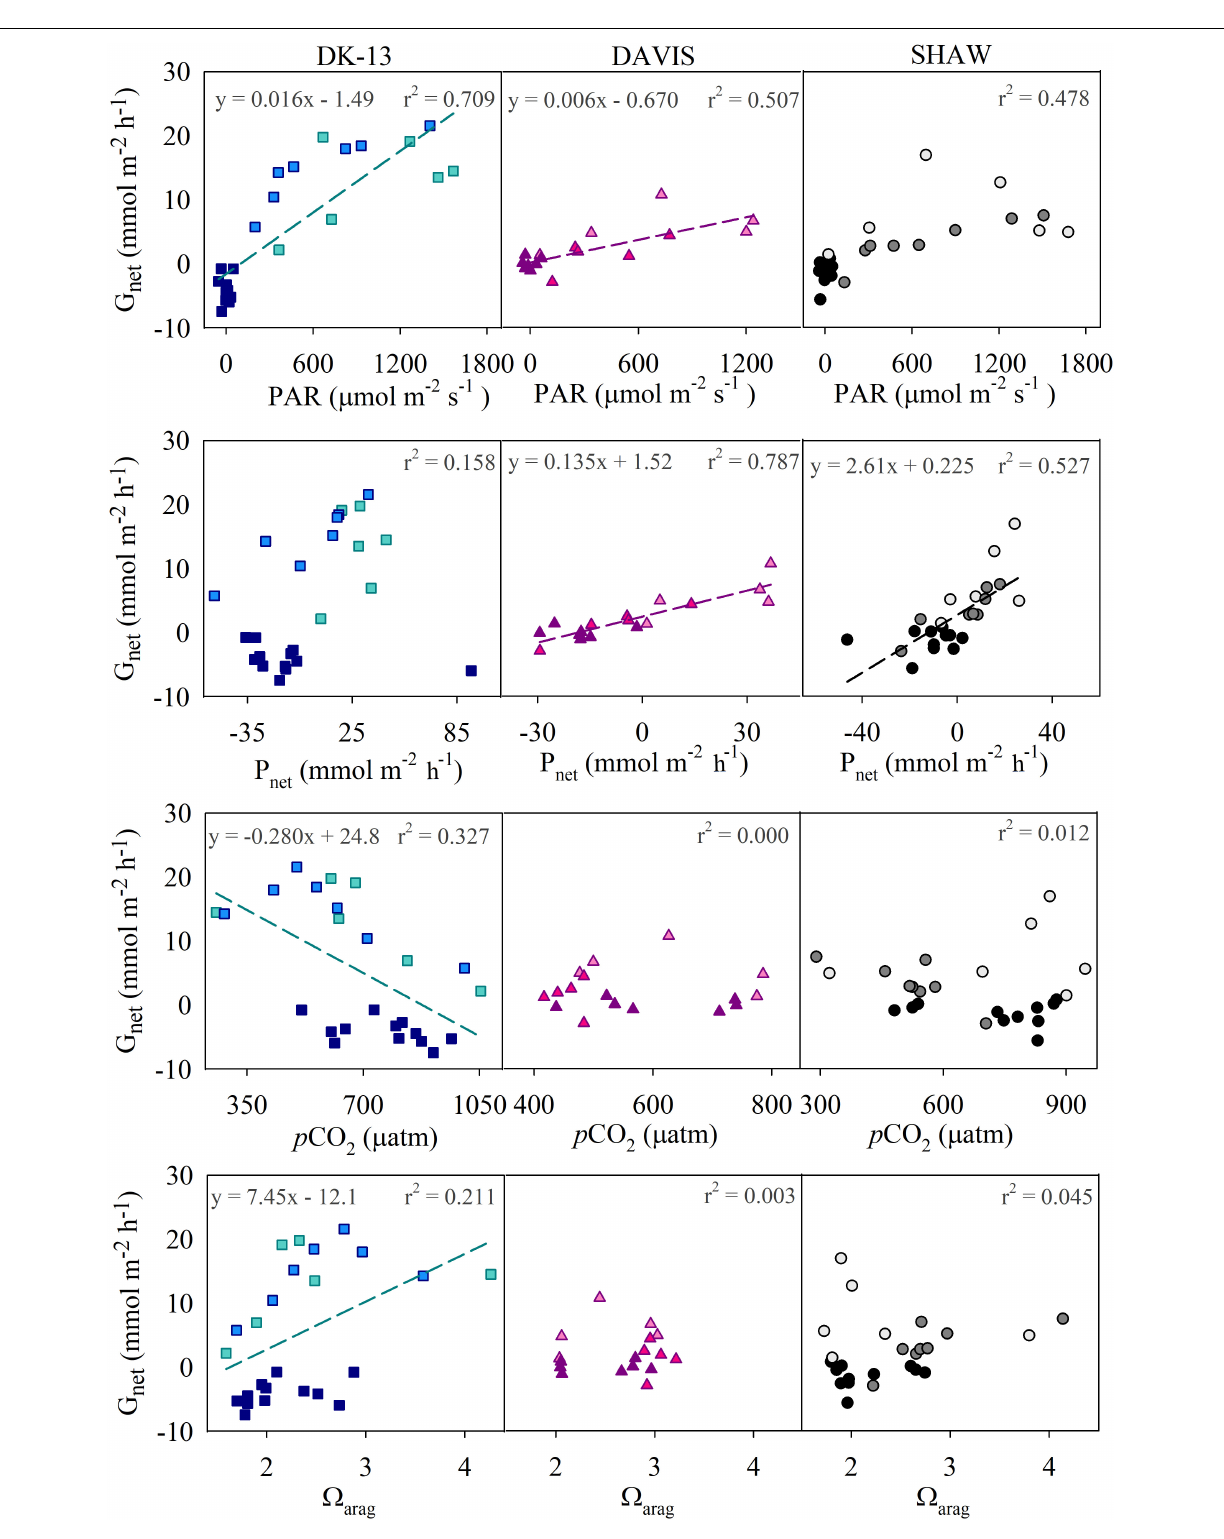
FIGURE 4 | Correlations between calcification and potential controls. Regression lines and equations refer to significant correlations ( p < 0.05). Note that G net and (cid:127) ar may initially appear to have hysteric loops at the DAVIS and DK-13 sites (see McMahon et al., 2013 for comparison). However, when the data are broken down into morning (lighter colors), afternoon (medium colors), and night (darker colors), the data are scattered and do not present a clear hysteric loop, though DK-13 has an overall positive correlation with (cid:127) ar regardless of time of